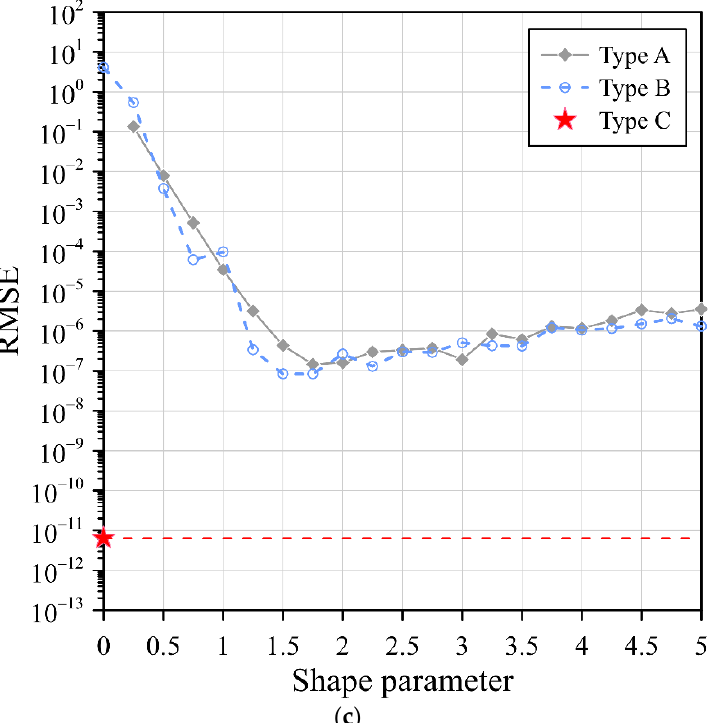
Figure 2. The RMSE of the three RBFs with three different collocation types: ( a ) Gaussian RBF, ( b ) MQ RBF, and ( c ) IMQ RBF.